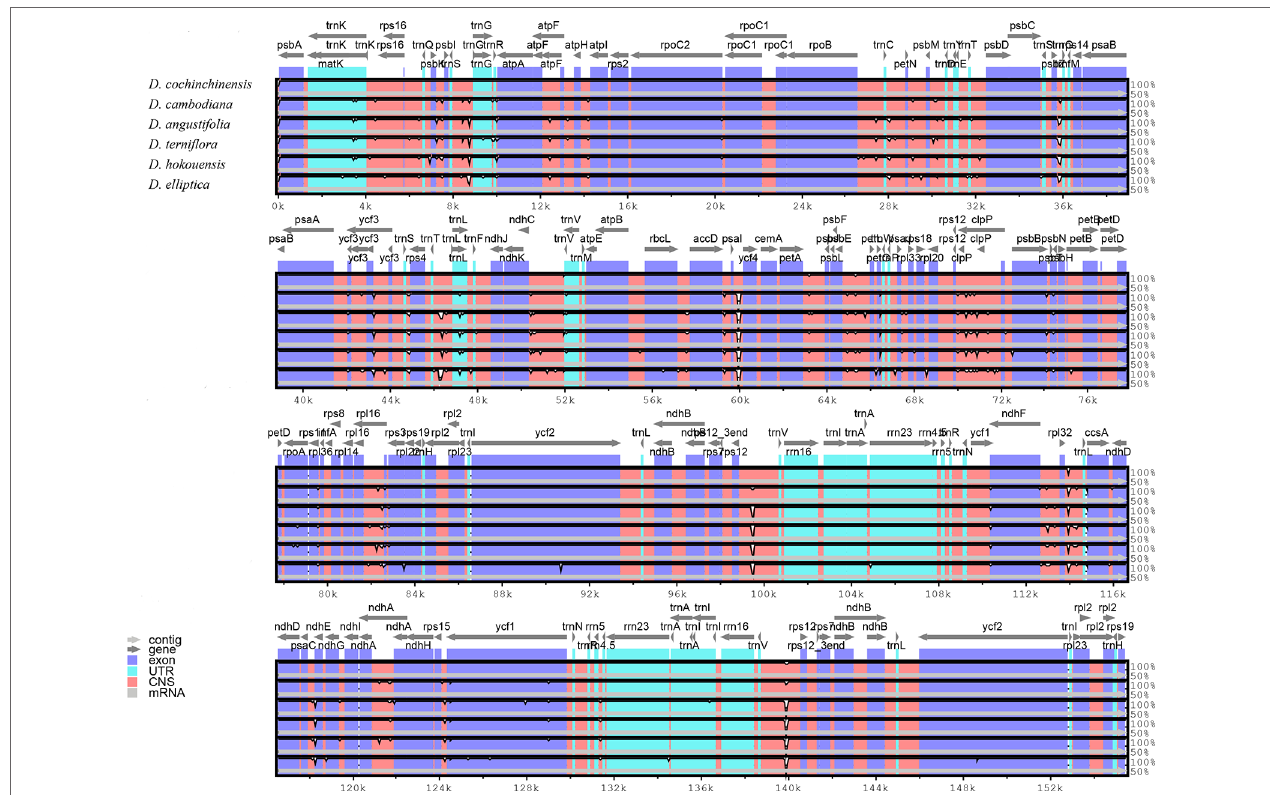
FIGURe 3 | Structure comparison of the six Dracaena CP genomes by using the mVISTA program. Gray arrows and thick black lines above the alignment indicate genes with their orientation and the position of the IRs, respectively. A cut-off value of 70% identity was used for the plots, and the Y-scale represents the percent identity between 50% and 100%.